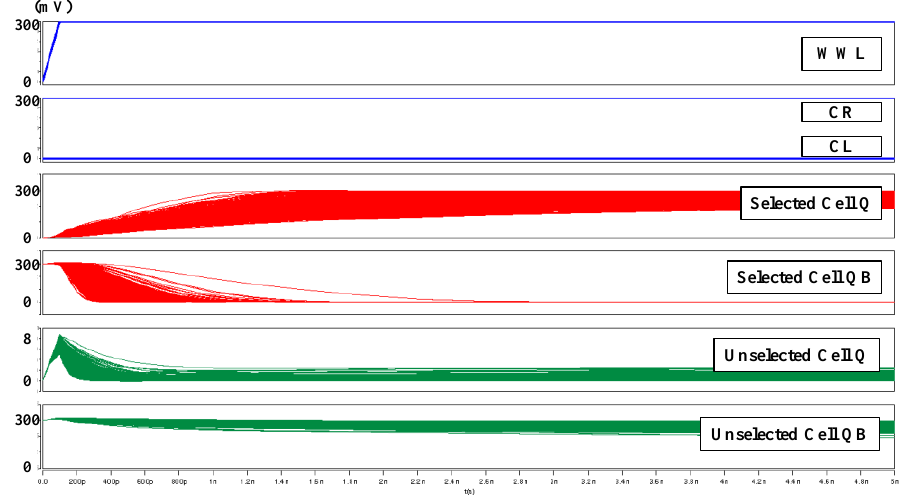
Figure 8. The 3000 times Monte Carlo simulation waveforms for column half-selected condition.